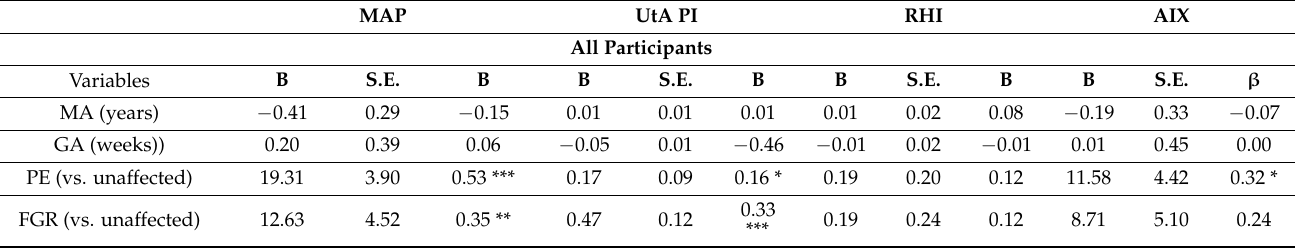
Table 5. Multiple regression